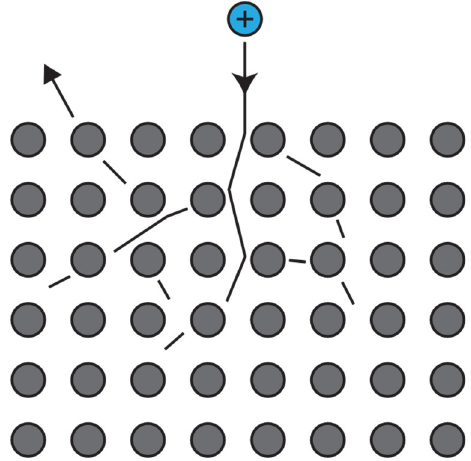
Figure 5. Sputtering mechanism according to the transport model [33]. An incident ion (blue) transfers energy to atoms (grey) and the resulting collision cascade propels an atom away from the surface.